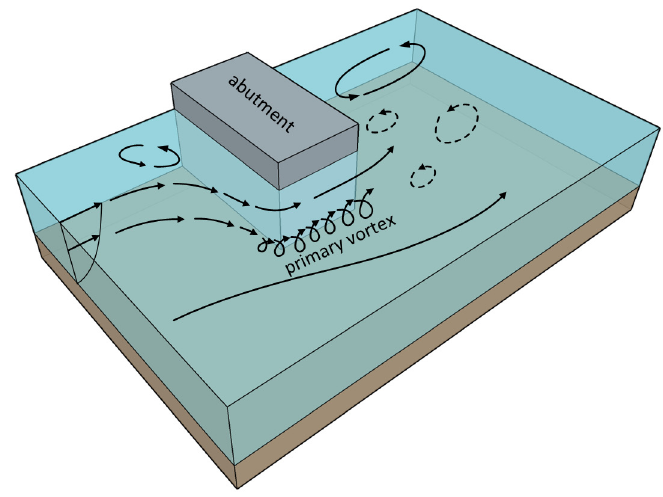
Figure 1. Schematic of flow structures around an abutment.